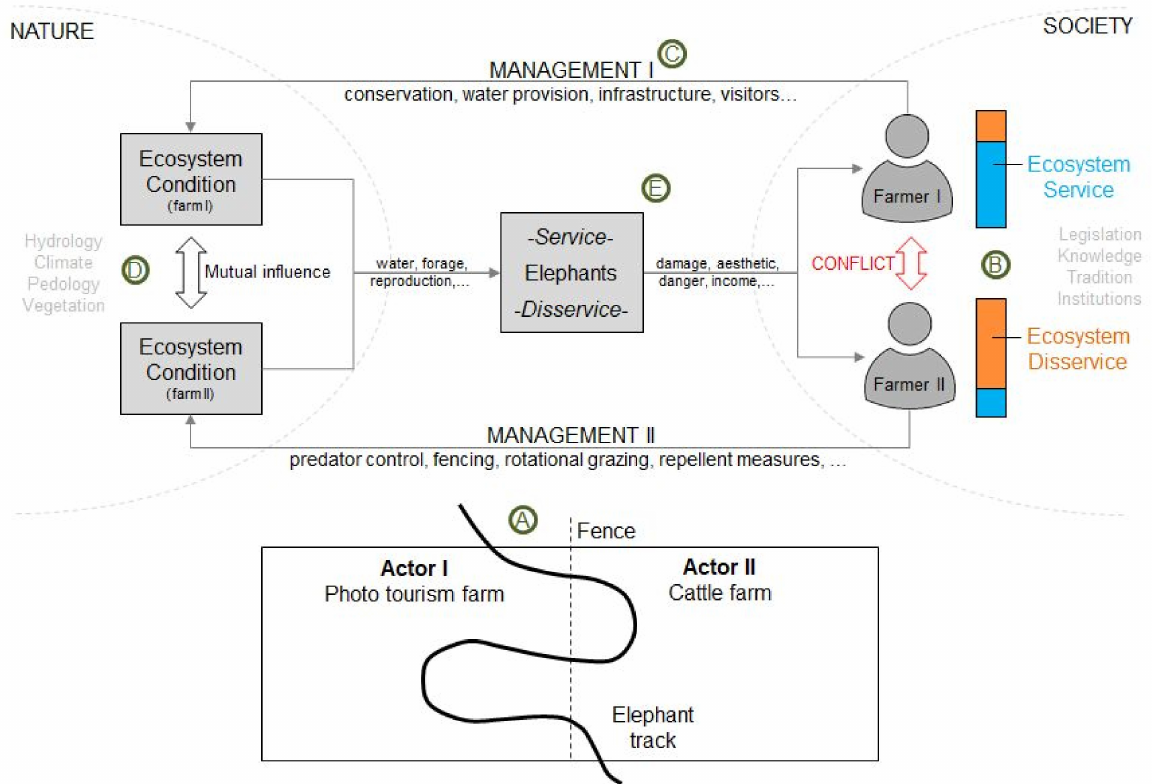
Figure 2. Conceptualization of how conflicts between stakeholders emerge due to diverging views on elephants as either ES or ESD. Adapted from